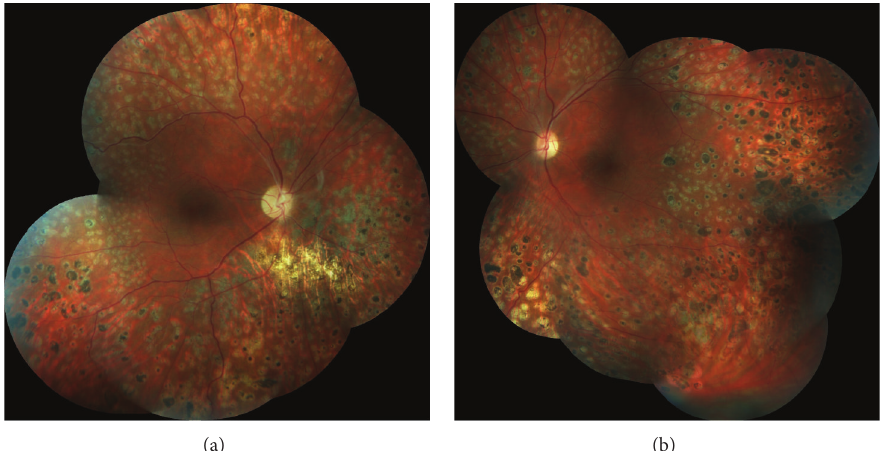
Figure 4: Composite color fundus pictures showing no sign of disease activity with the full laser scars of panretinal photocoagulation ((a) right eye, (b) left